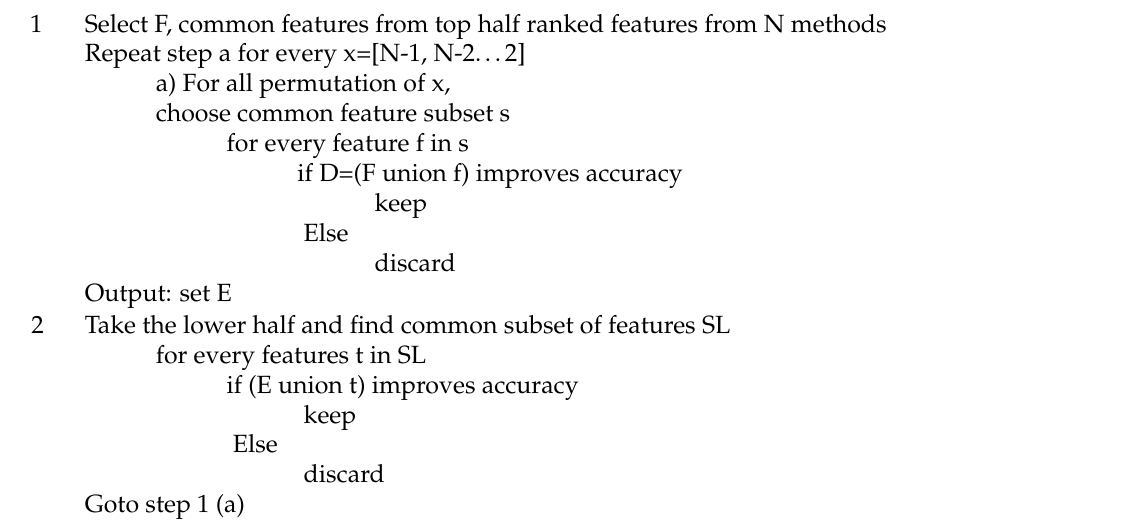
Algorithm 1 For finding feature subset using